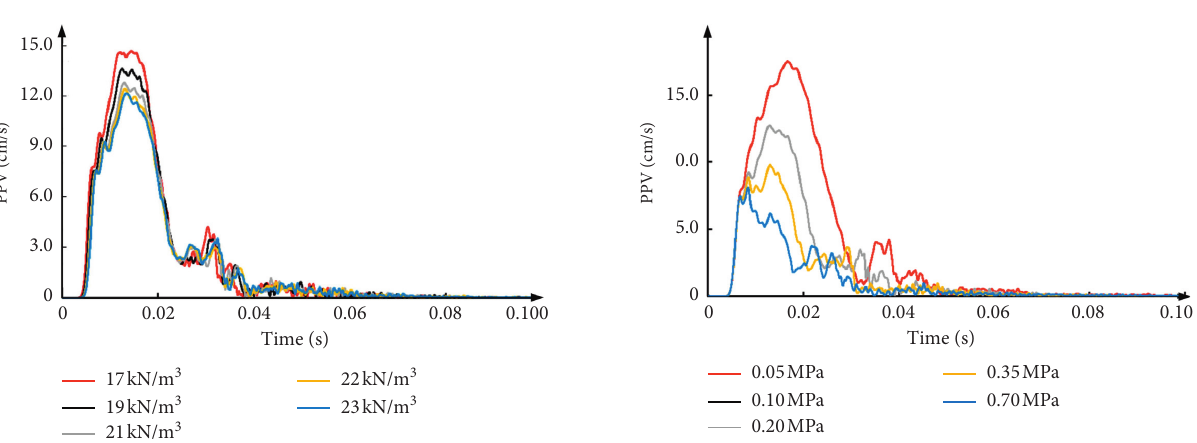
Figure 20: Changes of PPV of right wall with different cohesion versus